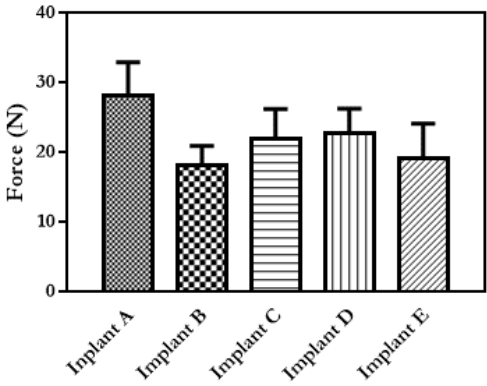
Figure 5. Force required to break each of the implant designs ( n = 5, means + SD).